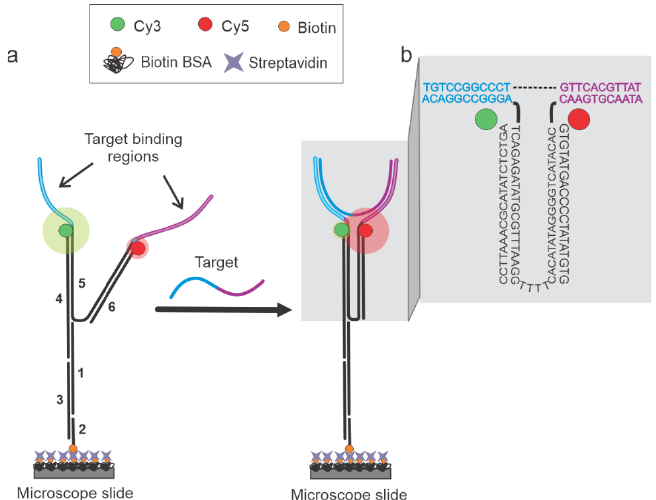
Figure 1. Working principle of the DNA nanotweezer (NT) sensor. ( a ) The sensor is made up of six strands (1: Strand 1, 2: Bio 5 ′ Comp, 3: Splint, 4: Cy3 Terminal, 5: NT-92a or NT-0, and 6: Cy5-Trunc, as identified in the Supplementary Table S1) and remains in the open conformation (low E FRET ) in the absence of a target. Target hybridization switches the sensor to the closed conformation (high E FRET ) since the target is complementary to one-half of each arm (target binding regions in blue and magenta). ( b ) Zoomed-in view of the NT, depicting the sequences for the NT-0 sensor specific for the DNA92a target (see Table S1 for sequences). The dashed line is used only to connect the two halves of the target sequence and no such gap exists in the real sequence.